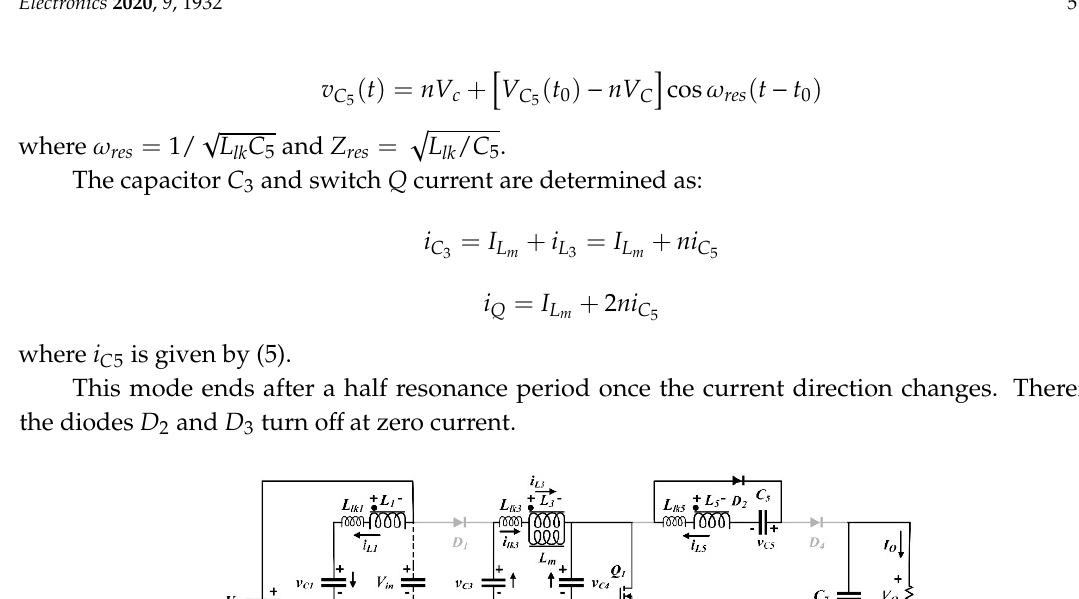
Figure 3. Circuit diagram of proposed converter with equivalent circuit of coupled inductors.